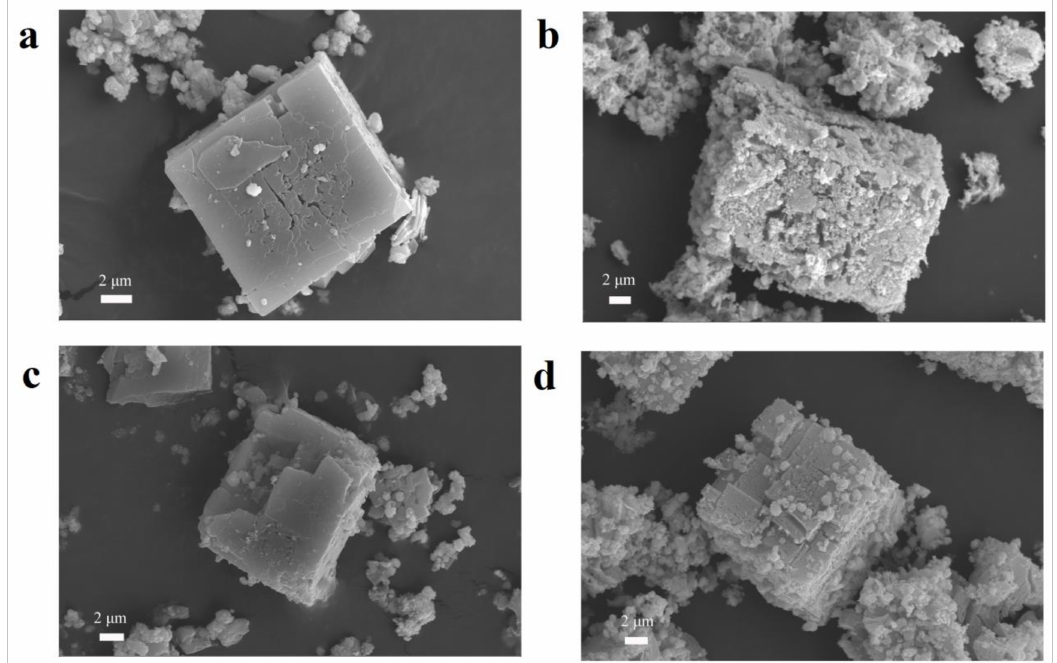
Figure 2. ( a – d ) SEM images of the metal oxide semiconductor (MOF)-5, ZnO, 5% Ni@MOF-5, and 5% NiO / ZnO